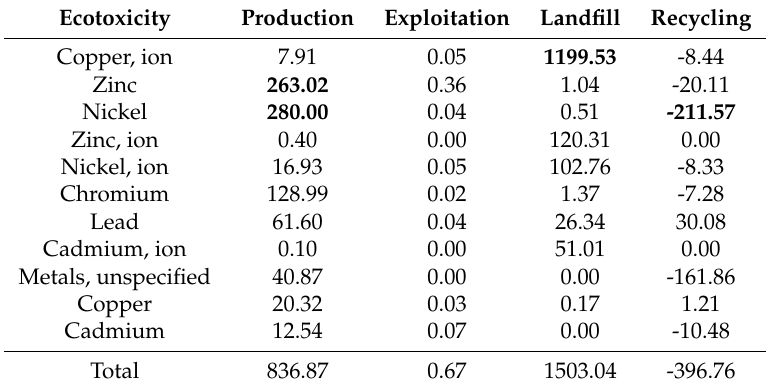
Table 10. Results of grouping and weighting of environmental after-e ff ects for ecotoxic compounds, occurring in the 1 megawatt photovoltaic power plant [unit: